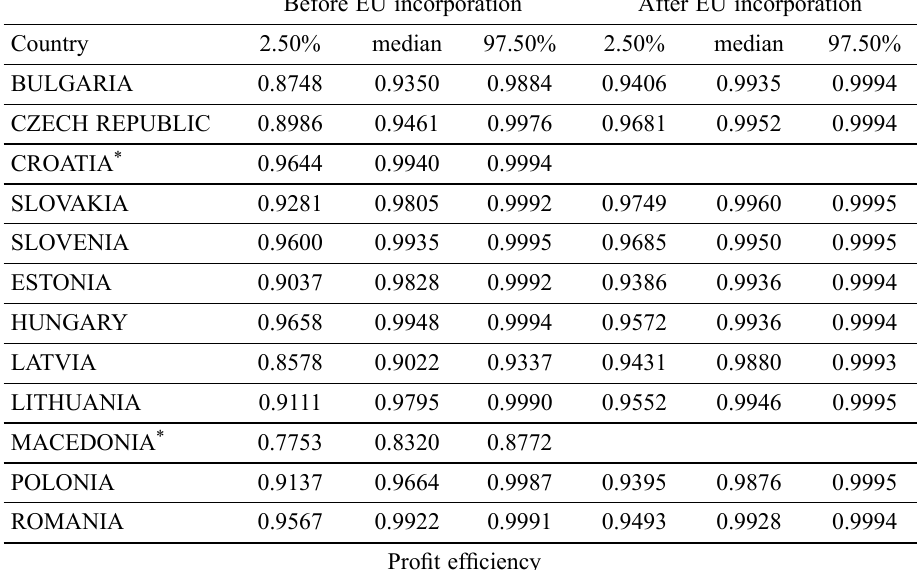
Table 6. Estimated mean bank efficiency for the each country before and after its incorporation into the EU Cost efficiency Before EU incorporation After EU